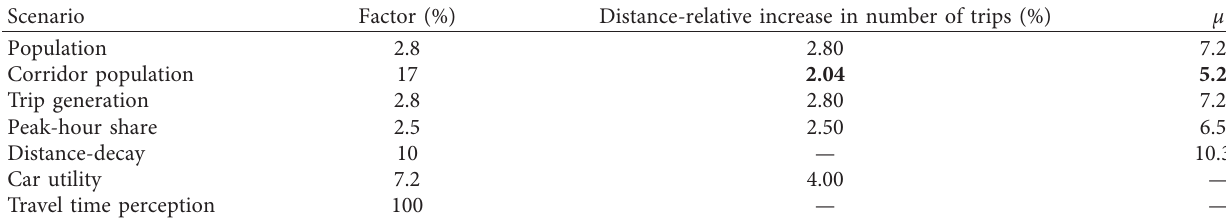
Table 2: The L-M points and μ values found in the analysed scenario.